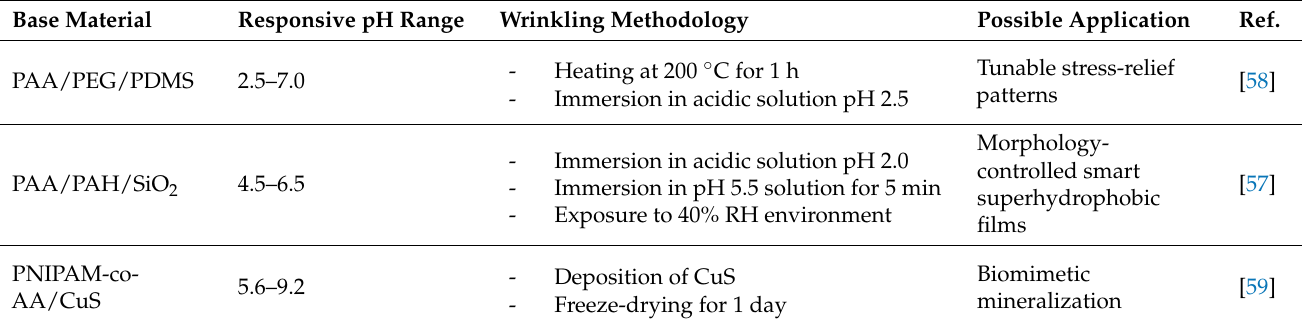
Table 2. Summary of pH-sensitive materials listed in Section